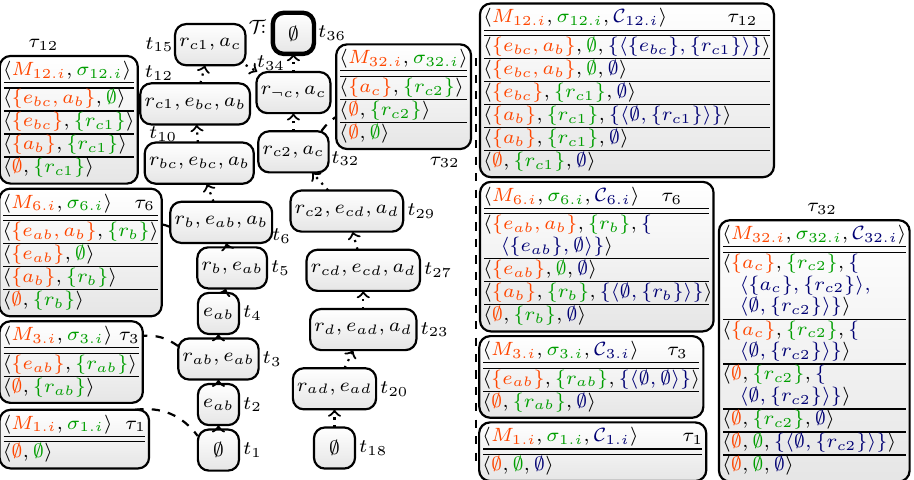
graph S ( P ) for program P from Example 1 ( center ). Selected DP tables after DP MOD ( left )